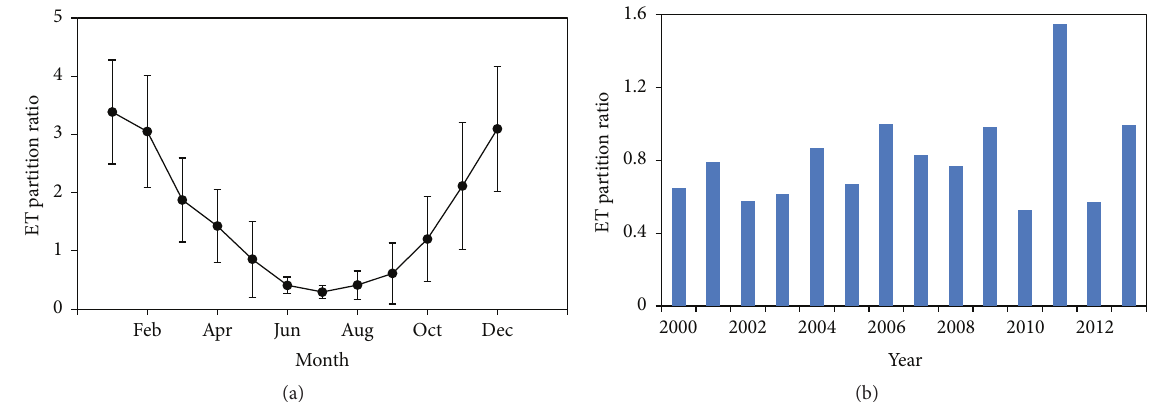
Figure 5: (a) Monthly and (b) annual variations in the ET partition ratio from 2000 to 2013; the error bars refer to ± 1 SD of the